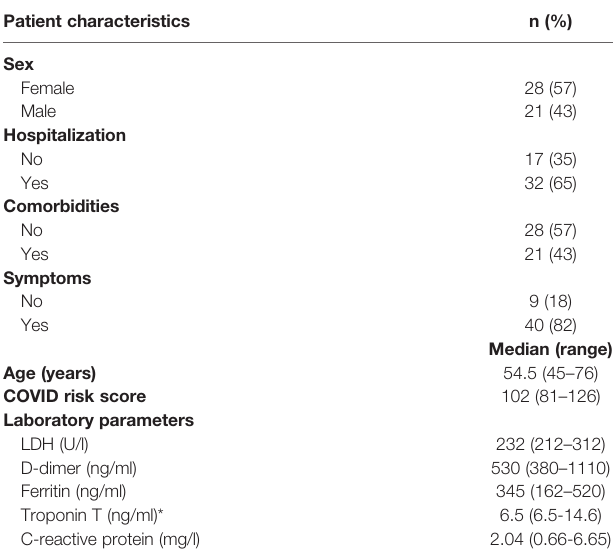
TABLE 1 | Demographic and clinical characteristics of the COVID-19 patients included in the